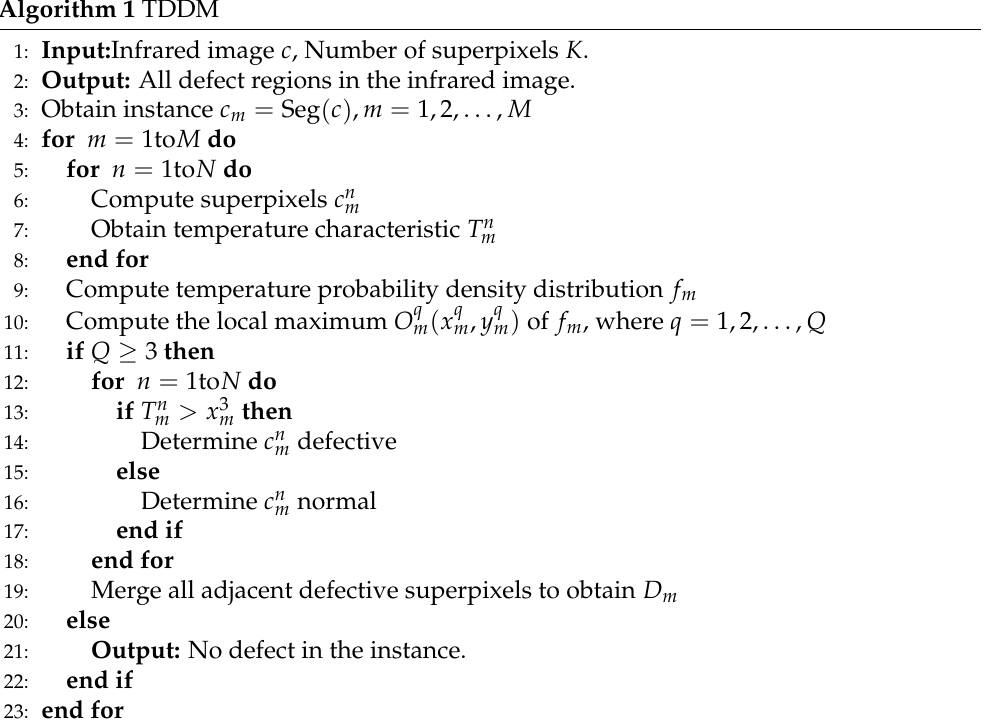
Algorithm 1 TDDM